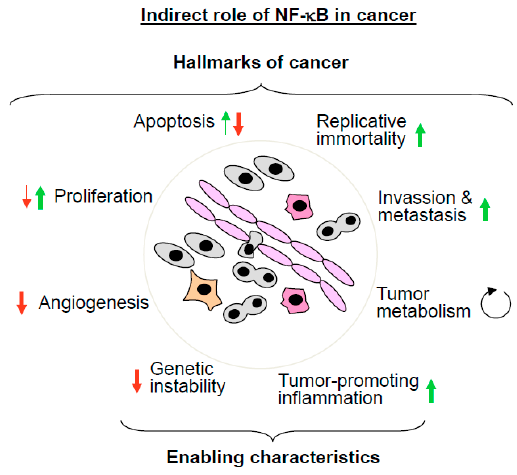
Figure 3. Schematic summary of the indirect roles of NF- κ B for the hallmarks and enabling characteristics of cancer. The relative thickness of the arrows indicates the estimated relative contribution of NF- κ B for the support (arrow up) or antagonism (arrow down) for the indicated processes.